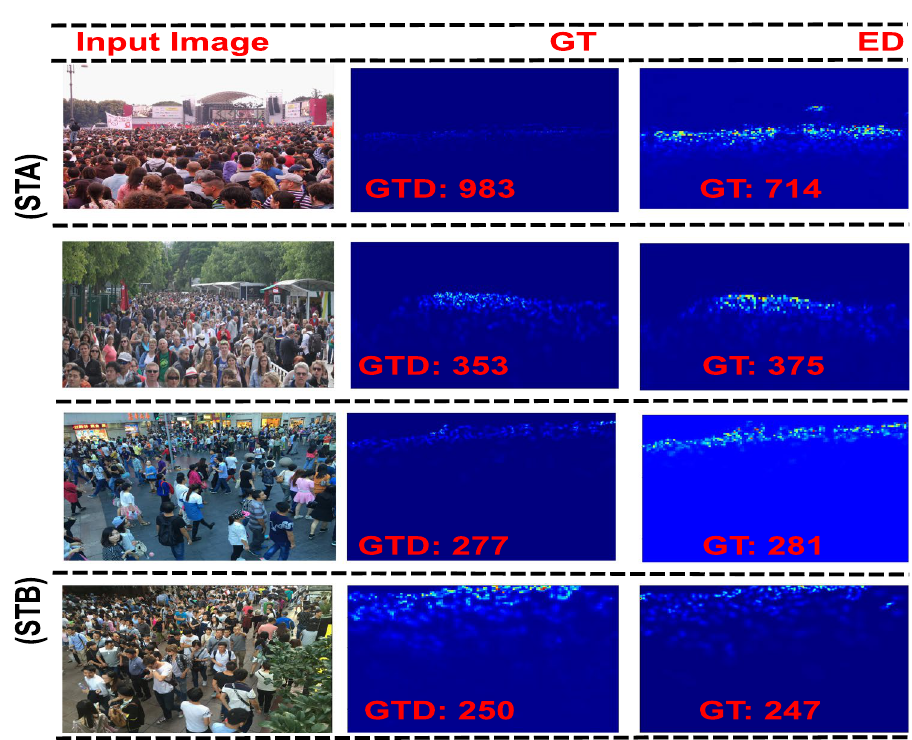
Figure 3. Visualization of ShanghaiTech Dataset (Part-A, Part-B) 7 , ground truth density, estimated